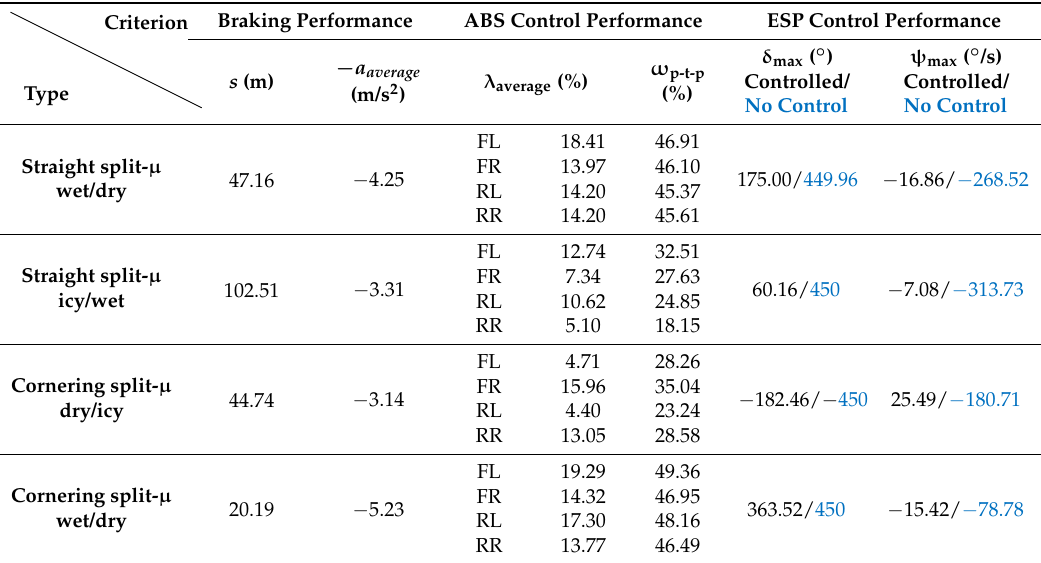
Table 6. Controller functionality